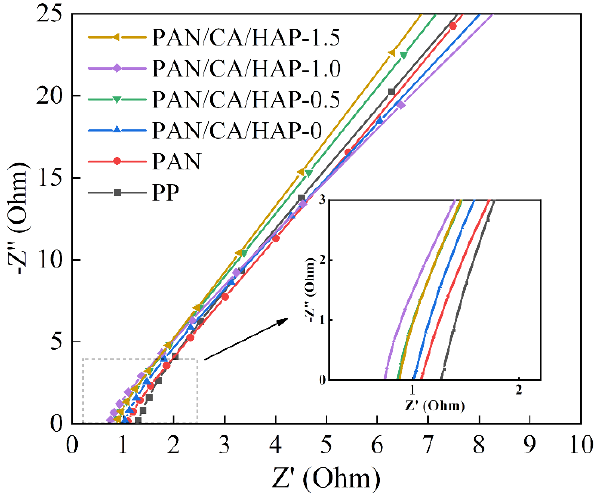
Figure 5. The electrochemical AC impedance spectra of CR2032 button cells assembled with differ- ent separators. Table 1. The thickness and ionic conductivity of different separators.